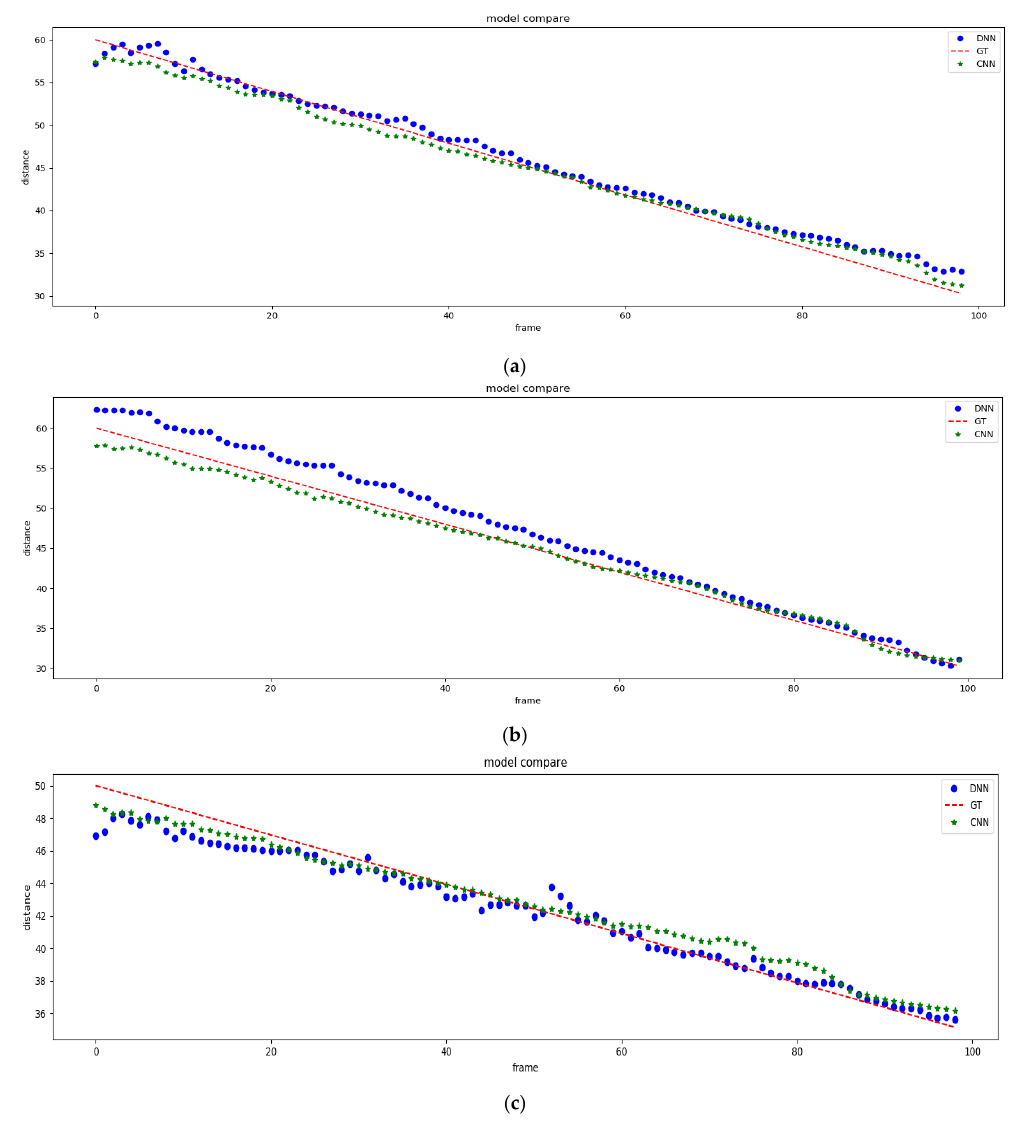
Figure 17. Comparison of CNN and DNN distance regression models: ( a ) and ( b ) the distance range of the intruder flying from 60 to 30 m; ( c ) the distance ranges from 50 to 35 m.